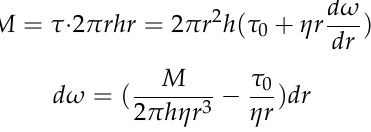
Figure 4. Schematic of the Intelligent Torque Rheometer.